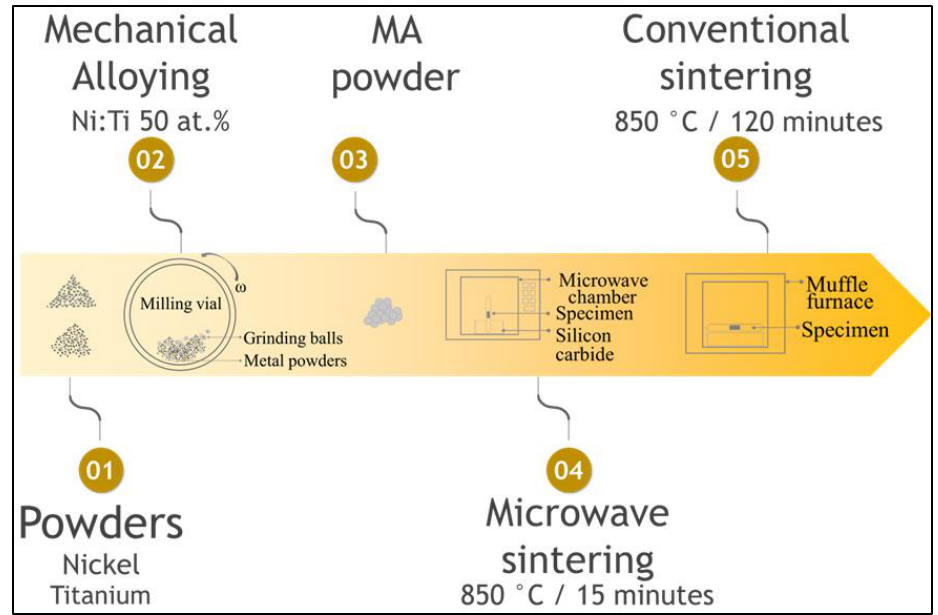
Figure 1. Schematic of the adopted mechanical alloying and sintering processes.